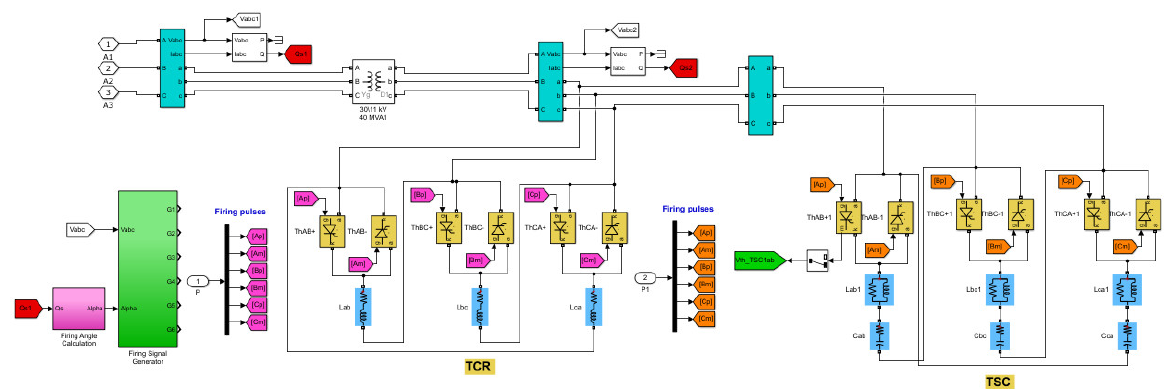
Figure 3. TSC-TCR 3-phase circuit diagrams with grid connection concept.